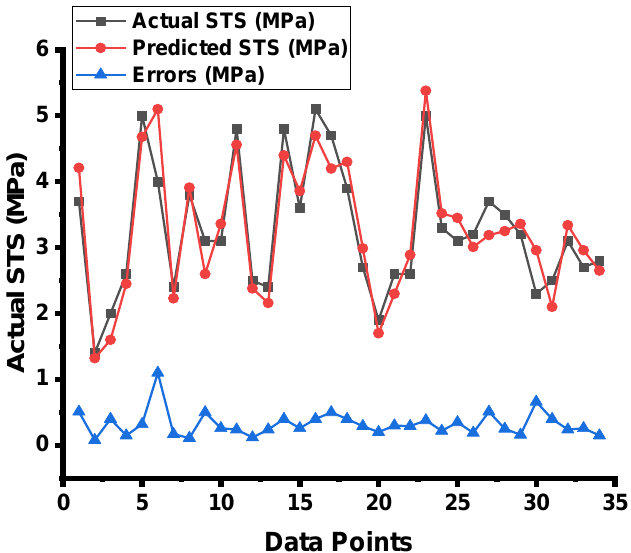
Figure 8. ANN model ’s actual results, predictions, and dispersal of their difference.